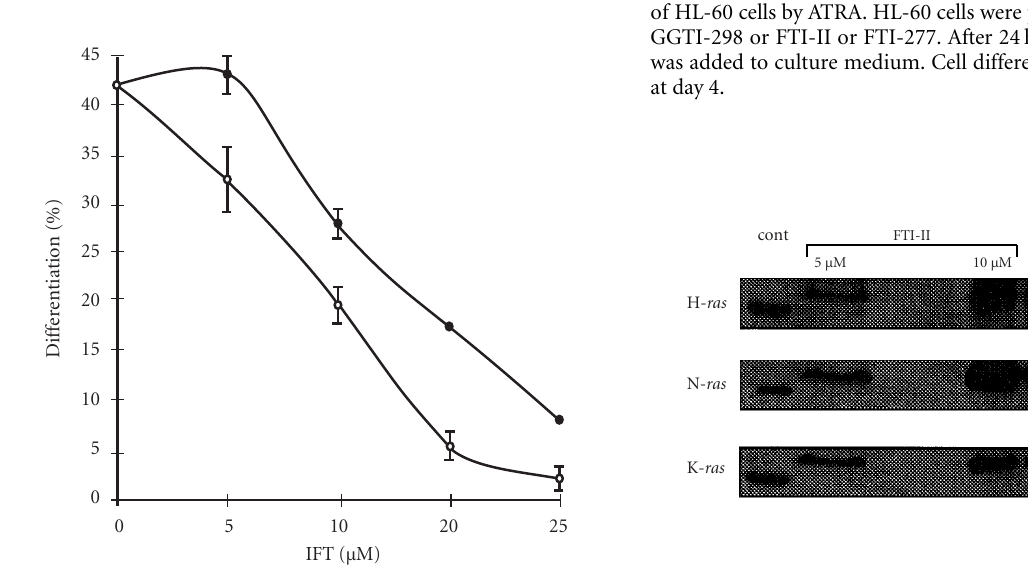
Figure 5: Inhibition of H-ras , N-ras , and K-ras prenylation by FTI- II,FTI-277,and GGTI-298 HL-60 cells were treated with 5 or 10 µ M of FTI-IIor10 µ Mof FTI-277orGGTI-298for24hours.Celllysates were analyzed by Western blotting with either a H-ras monoclonal antibody or a N-ras polyclonal antibody or a K-ras monoclonal an- tibody. Arrows, unprenylated ras